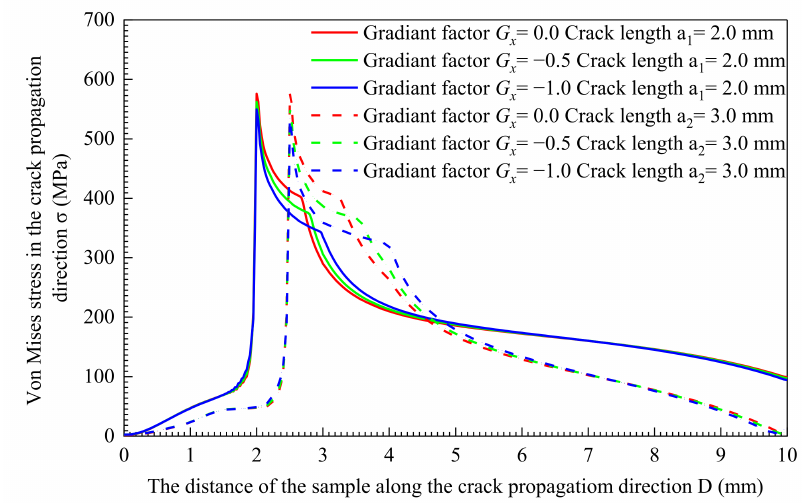
Figure 11. G x < 0 Von Mises stress distribution characteristics of materials along the crack propagation direction.